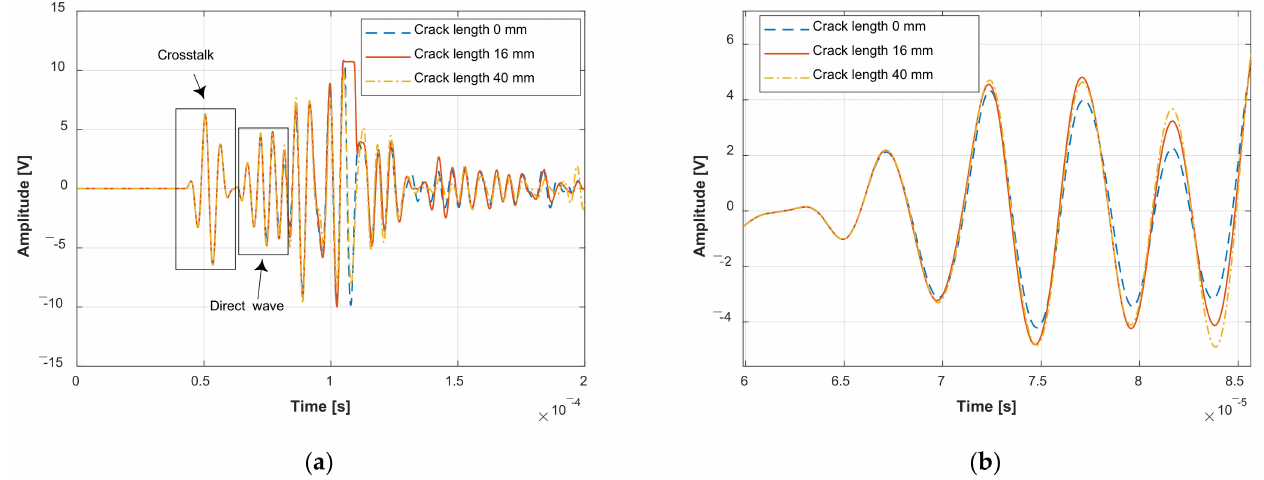
Figure 9. Typical guided wave signals with the increase of the crack lengths: ( a ) Whole guided wave signal collected during the fatigue test; ( b ) Magnification of the direct wave packet of the collected GW signal.